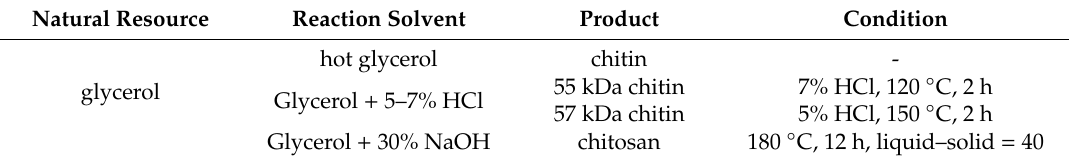
Table 1. Glycerol as the reaction solvent for extraction of chitin and chitosan. Natural